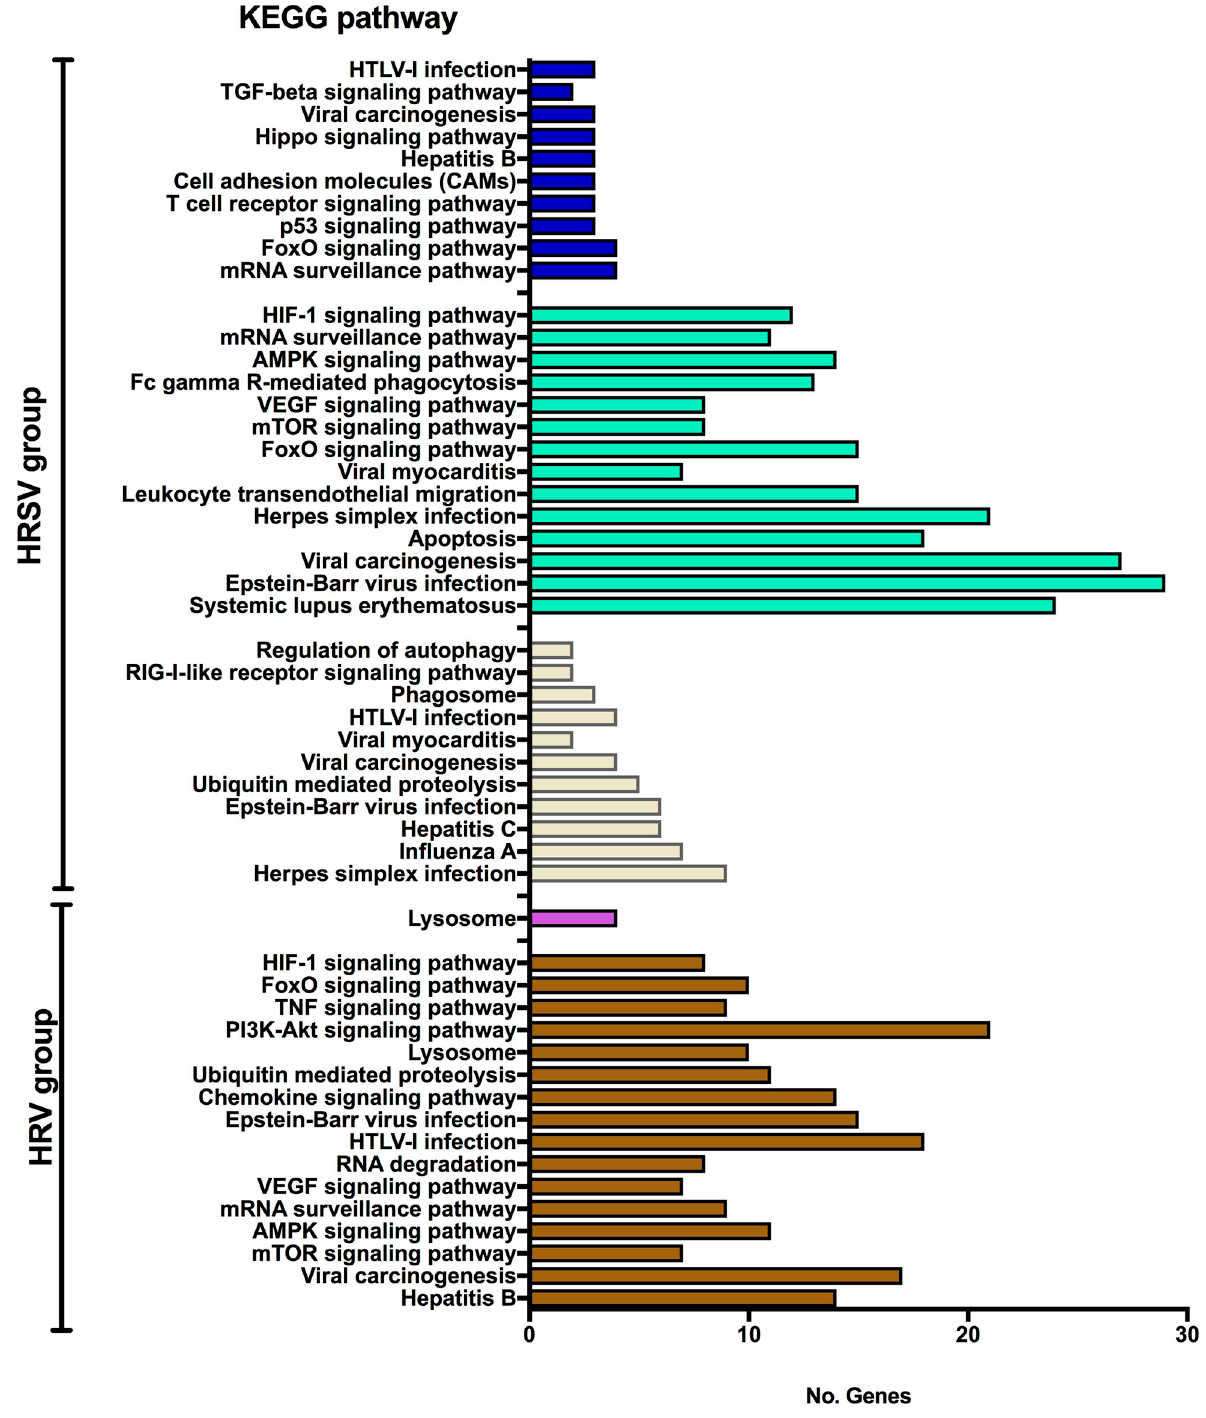
Fig 3. KEGG enrichment analysis of significantly associated modules with HRSV or HRV groups. Midnight blue (MS = 0.79, p = 0.002), turquoise (MS = 0.69, p = 0.01) and tan (MS = 0.63, p = 0.03) are modules positively associated with HRSV. Purple (MS = 0.78, p = 0.003) and brown (MS = 0.59, p = 0.04) are modules positively associated with HRV. The bar colors correspond to each module.